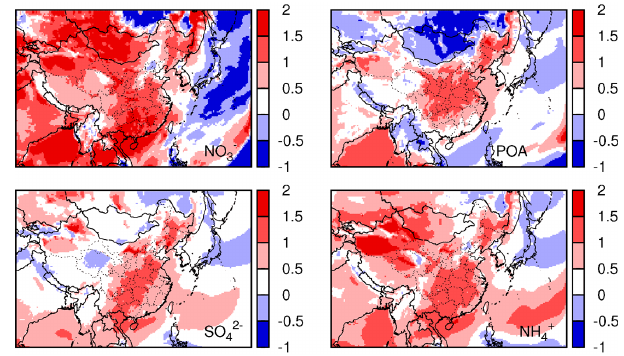
) , sulfate (SO 2 − ) , am- Figure 8. Deviation of winter nitrate (NO − 3 4 ) , and primary organic aerosol (POA) from an- monium ion (NH + 4 nual average, as calculated by (W − A)/A , where W and A are win- ter and annual concentrations